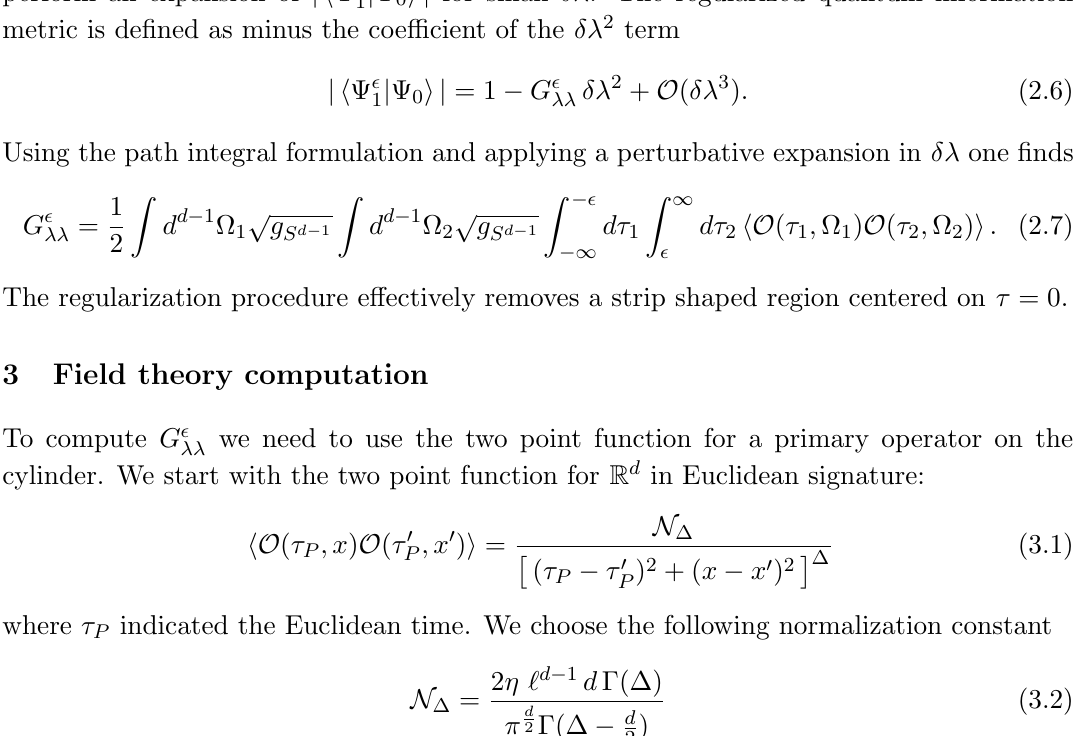
S d (cid:0) 1 (cid:2)